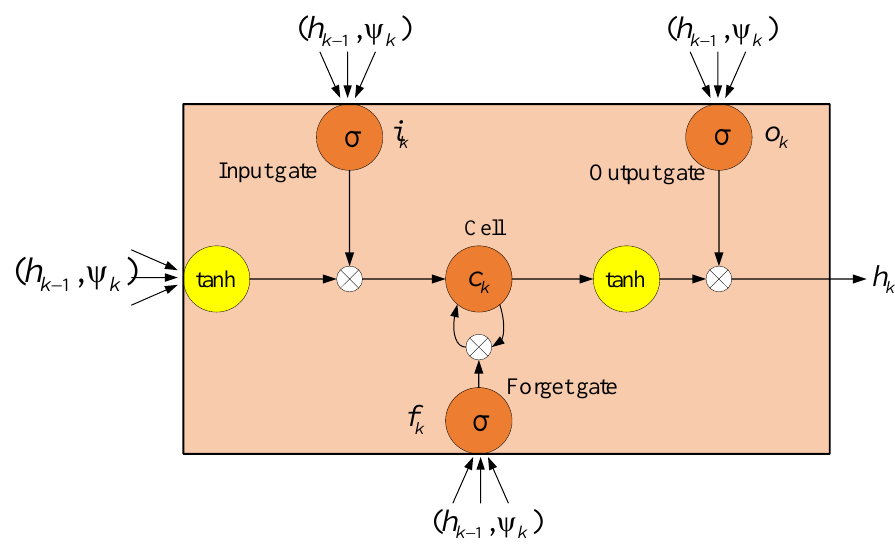
Figure 6. Network architecture of the LSTM-RNN.